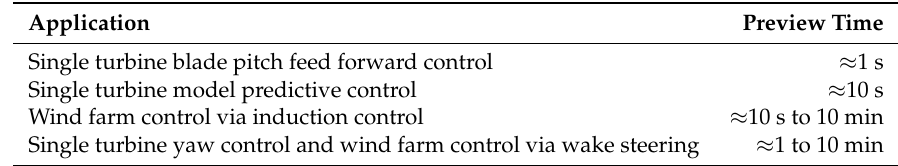
Table 1. Helpful wind preview times for various wind turbine and wind farm